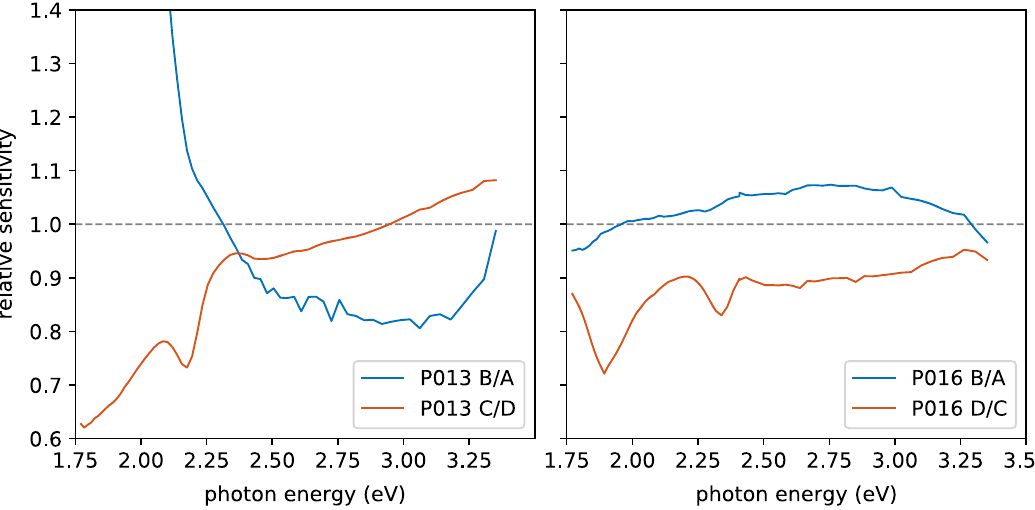
FIG. 5. Relative sensitivity of the samples P013 and P016 during the various cycles. The horizontal line at unity is to guide the